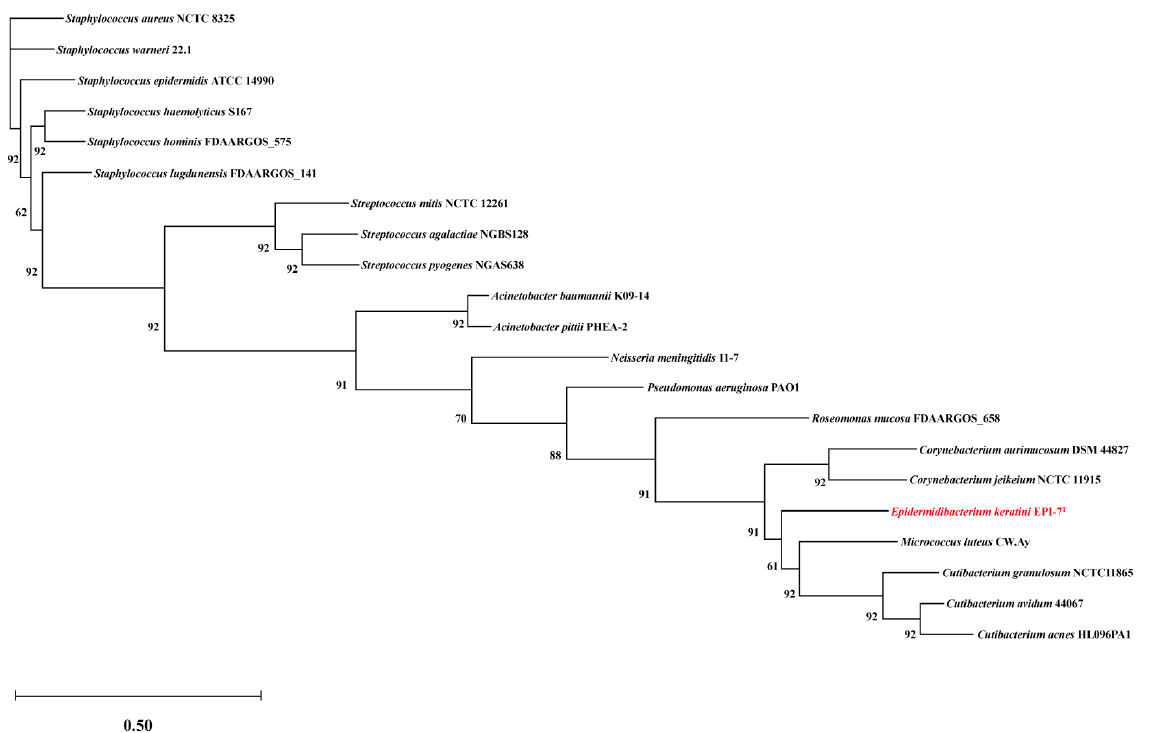
Figure 4. Genome-based phylogeny analysis with E . keratini EPI-7 T and the 20 prominent skin microbiota in humans using UBCG. Evolutionary distance based on the 92 core genes selected by UBCG shows the relevant relationship between E . keratini EPI-7 T and 20 human skin microbiotas. Bootstrap analysis was performed at 100 replications. Bootstrap values are given at branching points. Bar, 0.50 substitution per position. It can be confirmed that the E . keratini EPI-7 T (in red) is the most relevant relationship with Micrococcus luteus . On the contrary, the most independent branch is formed at Staphylococcus and Streptococcus